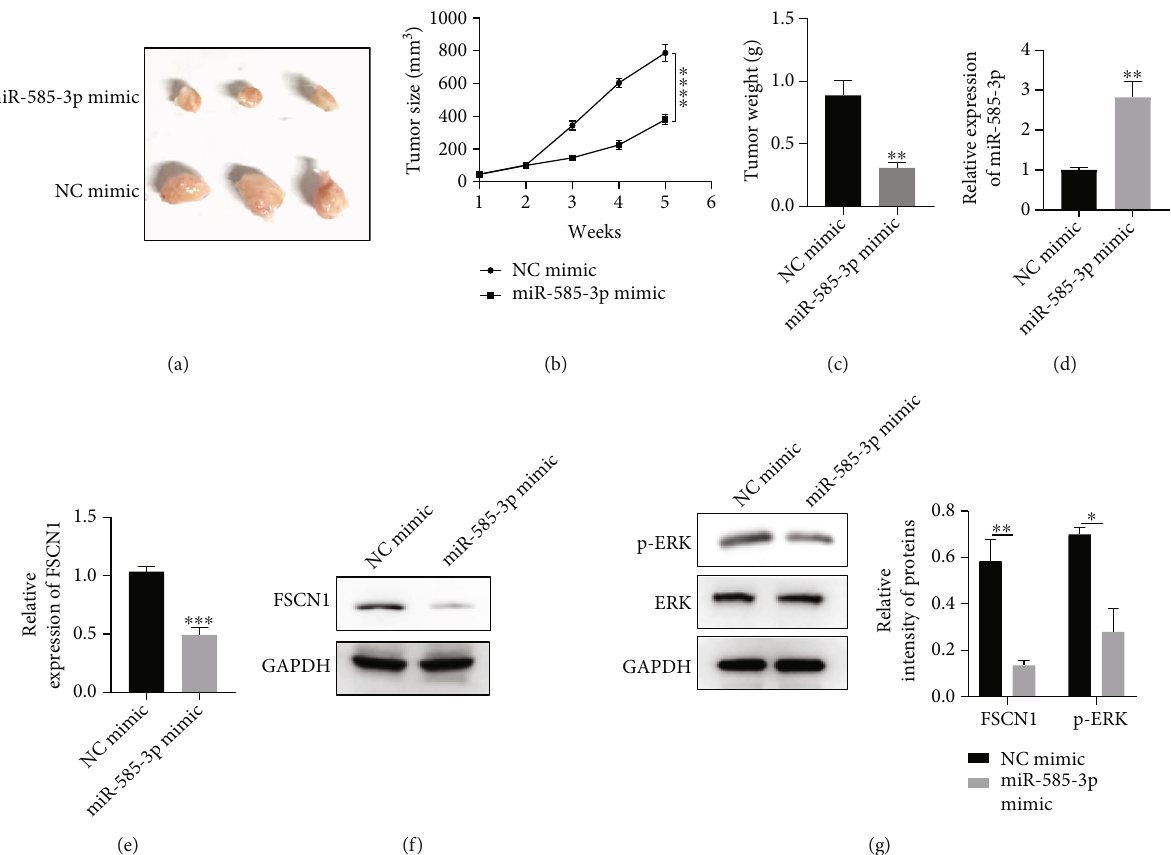
Figure 6: Overexpression of miR-585-3p inhibits the proliferation of OC tumor in vivo. (a) Overexpression of miR-585-3p inhibits the growth of OC tumor in vivo. (b) Overexpression of miR-585-3p restrains the growth of OC tumor volume in vivo. (c) Overexpression of miR-585-3p restrains the weight growth of OC tumor. (d) RT-qPCR was used to detect the relative expression level of miR-585-3p after OC cells were transfected with miR-585-3pmimic. (e) Overexpression of miR-585-3p inhibits FSCN1 mRNA expression. (f) Overexpression of miR-585-3p inhibits the expression of FSCN1 protein. (g) Overexpression of miR-585-3p inhibits the expression of p-ERK protein. ∗ P < 0 : 05 , ∗∗ P < 0 : 01 , ∗∗∗ P < 0 : 001 , and ∗∗∗∗ P < 0 : 0001